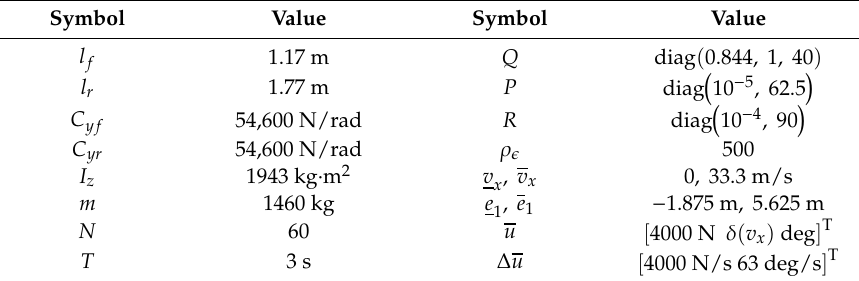
Table 1. Parameters of dynamical model and nonlinear program.